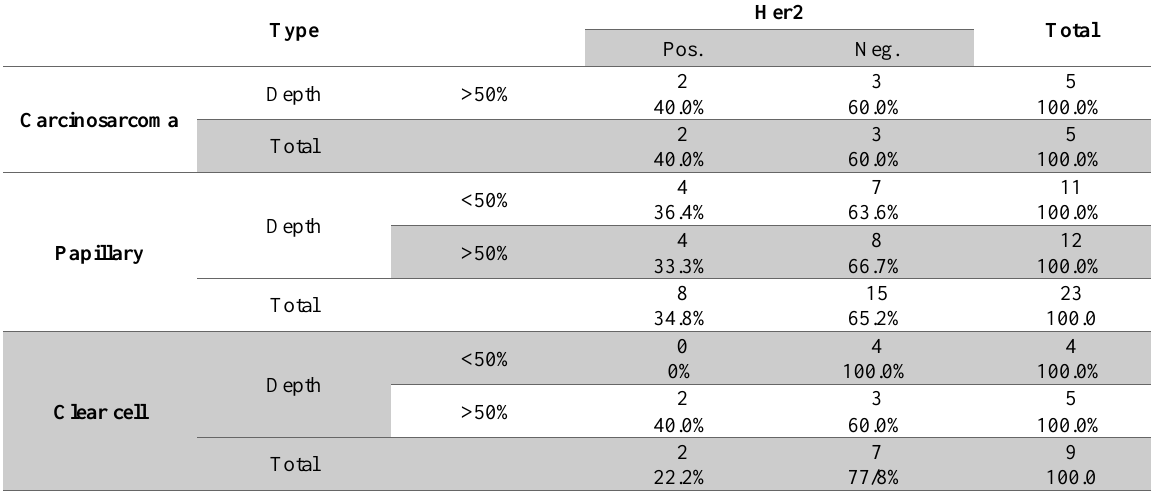
Table 3. Her2/neu overexpression and depth of myometrial